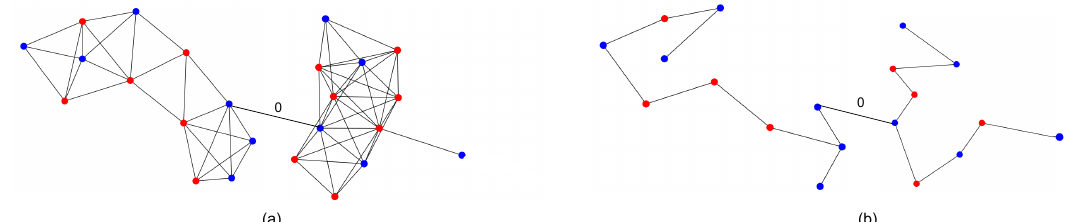
Figure 29. Multi-source graph example. Graph ( a ) is a full red–blue visibility graph comprised of two subgraphs with a single connecting edge (with weight 0). Graph ( b ) is the GA result for graph (a). Note that because we artificially connected two subgraphs with a single edge of weight 0, we can run the algorithm on each subgraph separately and achieve the same